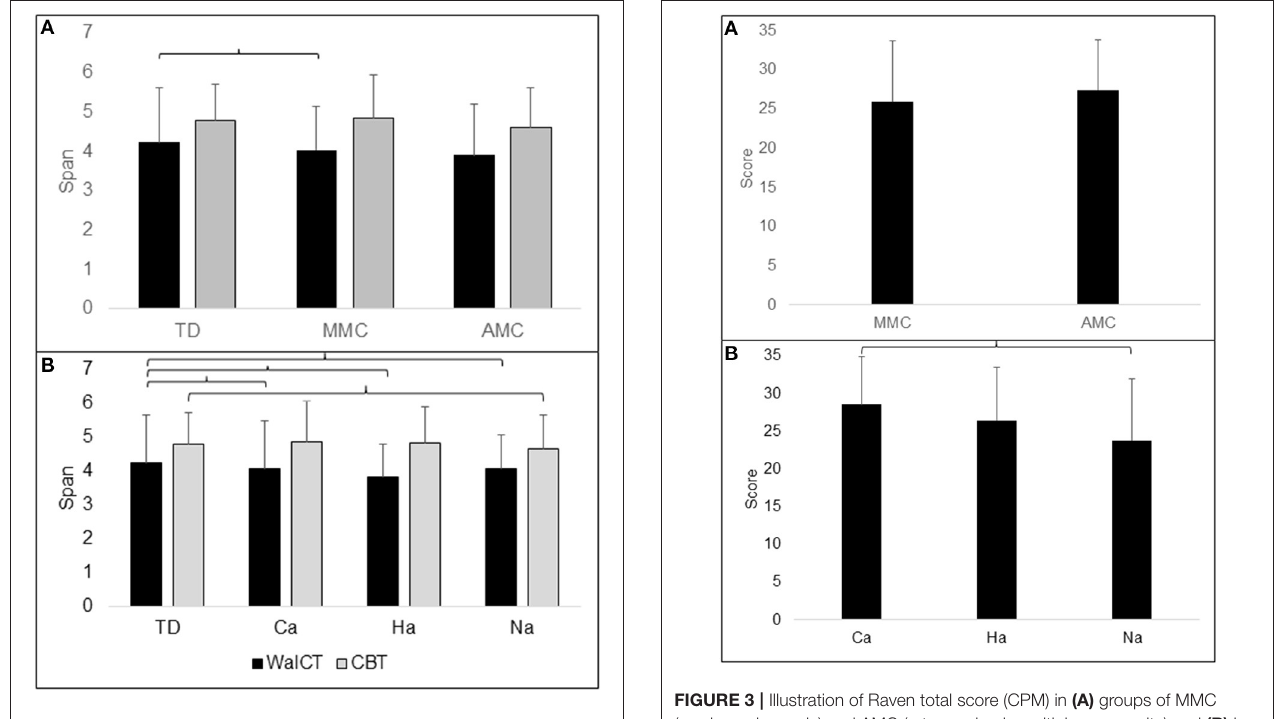
FIGURE 2 | Illustration of topographical (WalCT) and visuospatial (CBT) working memory in (A) groups of TD (typical developing children), MMC (myelomeningocele) and AMC (artrogryphosis multiplex congenita) and (B) groups of Ca (community ambulation), Ha (household ambulation) and Na (non-ambulation). The number of spans with standard deviation (SD) is shown on the y-axis. Parentheses indicate significant difference.